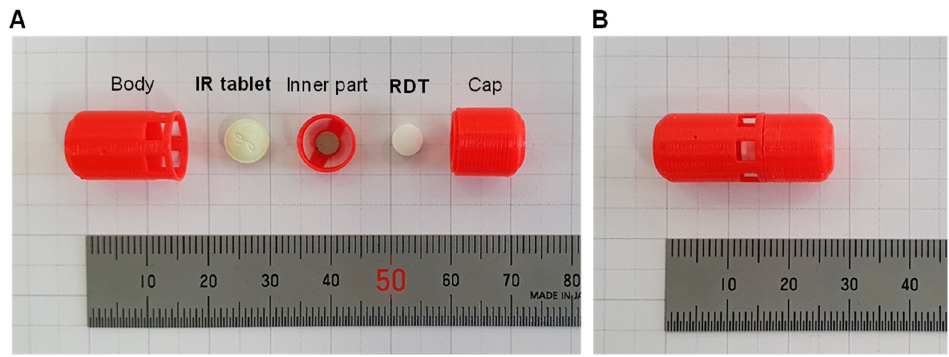
Figure 1. Components of the gastroretentive sustained release drug delivery system, i.e., 3D-printed capsular device, RDT, and IR tablet ( A ) and a final drug delivery system after assembly ( B ).